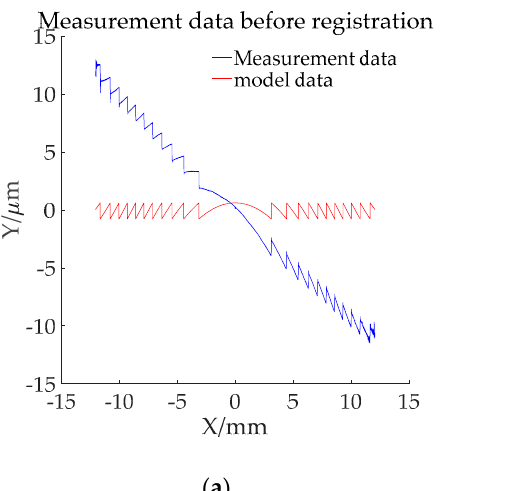
( b ) Figure 4. Measured data filtering. ( a ) Before filtering; ( b ) after filtering. To realize the data registration, the Sparse iterative closest point (ICP) algorithm was used to match the design model data with the measured data. The basic idea was to find the nearest point in the geometric relationship in the two sets of data to form a matching point pair, and then to find the matrix parameters of rotation and translation of the rigid body transformation that make the geometric distance between all point pairs shortest, based on the least squares method. Then continuous iterative optimization until the distance correlation parameter between two pairs of datasets was less than a certain threshold. The Sparse ICP algorithm has been improved on the basis of traditional ICP. It can be described as follows:   n